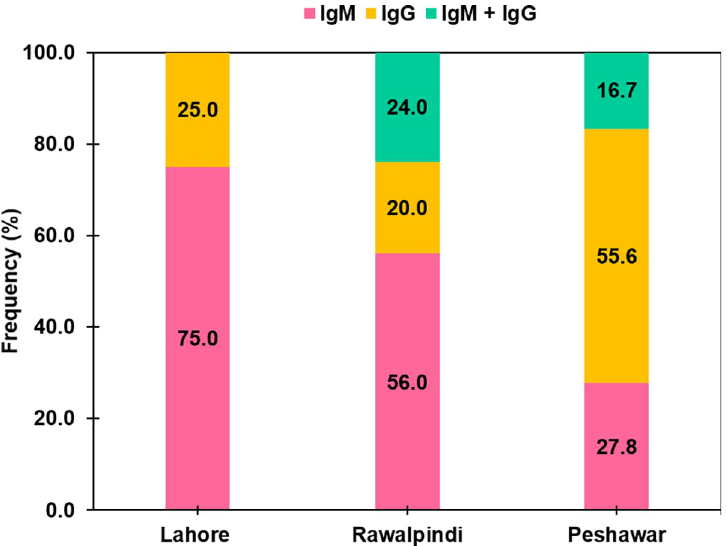
Fig 4. Seroprevalence of Chikungunya virus co-infection in dengue cases reported from Lahore ( n = 4), Rawalpindi ( n = 50) and Peshawar ( n = 18).